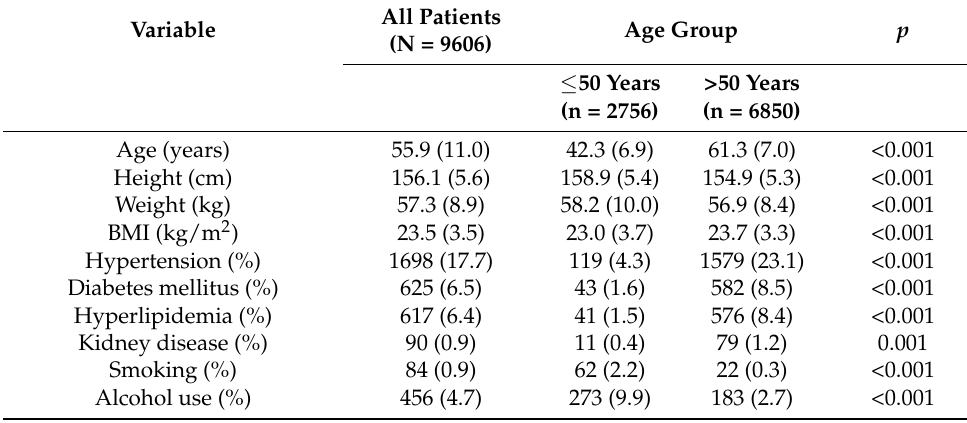
Table 1. Demographic and clinical characteristics of the patients (N = 9606).